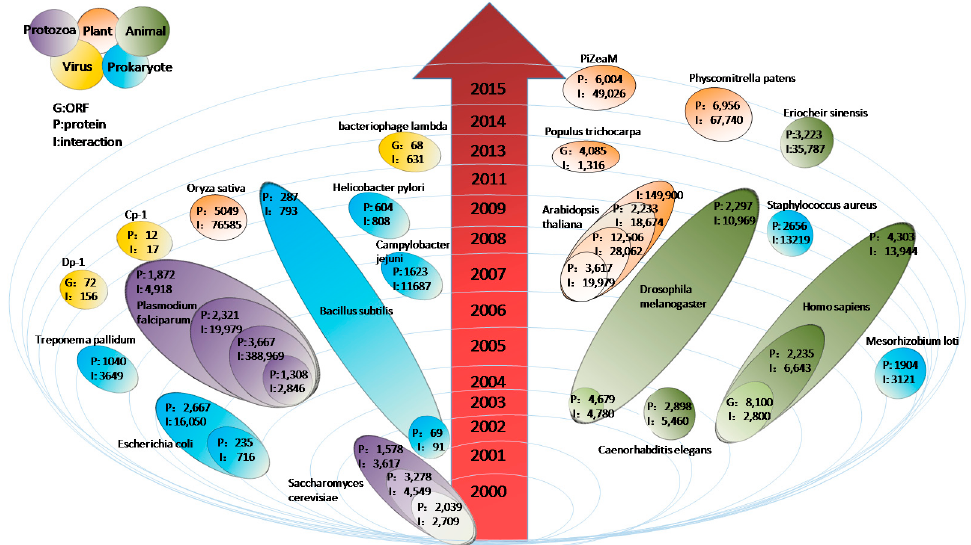
Figure 1. A time chart of the PINs reconstructed in the past fifteen years. The timeline is marked by ellipsoids placed to indicate the year that the PIN was published. The yellow, blue, purple, red, and green ellipsoids represent virus, prokaryote, protozoa, plant, and animal, respectively, for which the PINs have been reconstructed. The letters G, P, and I represent the number of ORFs, proteins, and interactions, respectively, in the indicated version of the PIN. For multiple models of the same species, the numbers of ORFs/proteins and interactions are distinguished by different shades of a color.